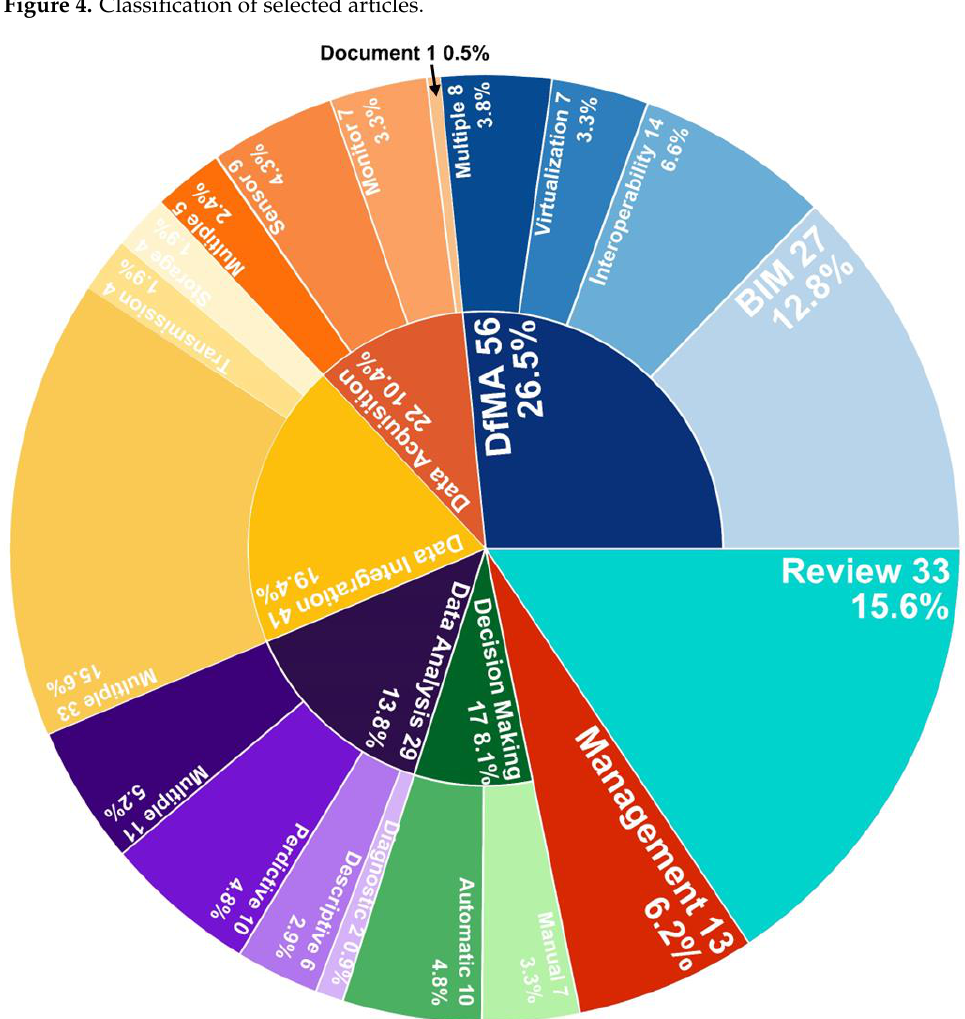
Figure 5. Percentage of publication categories.